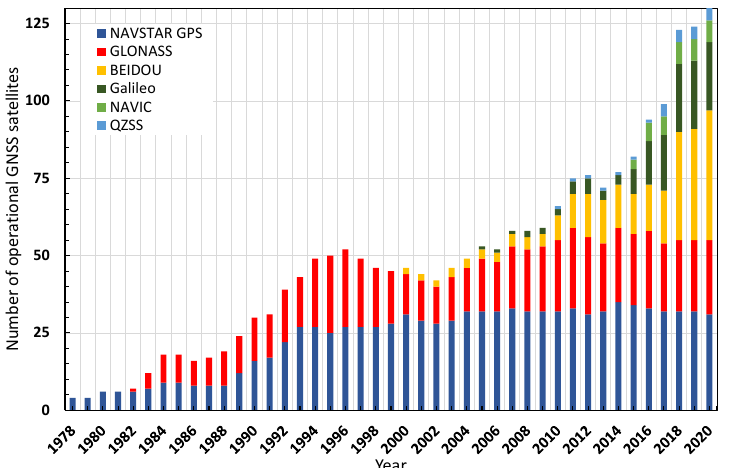
Figure 1. Available operational GNSS/RNSS satellites as a function of years and systems from 1978 to mid-2020 (data sources: